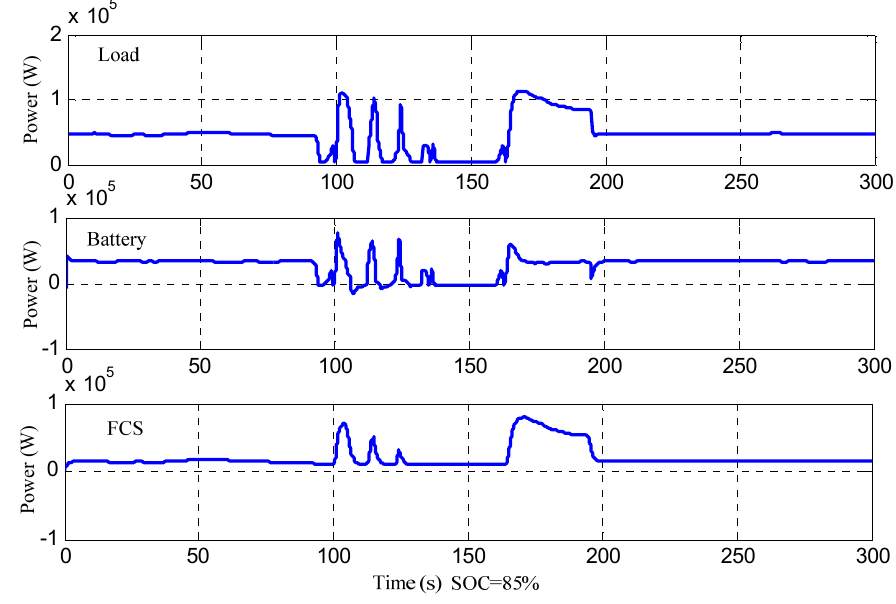
Figure 19. Power of load, FC and battery for Case 3.